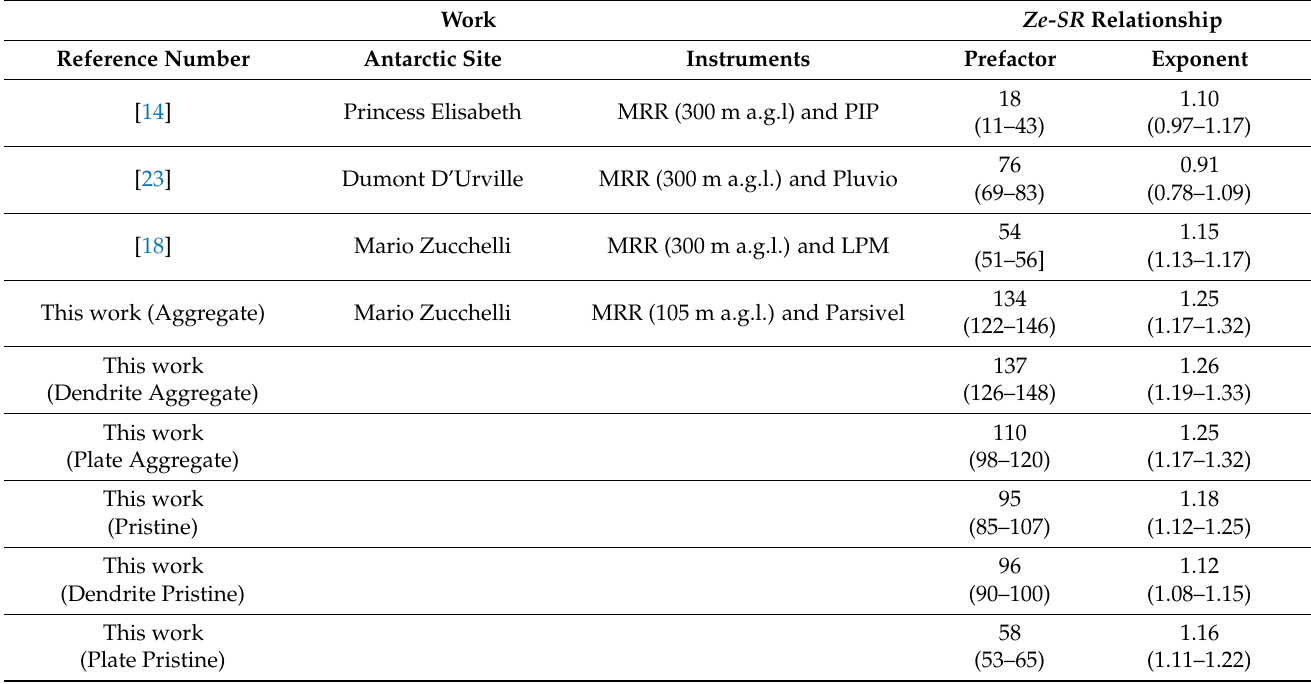
Table 2. List of the Ze-SR parameters in the literature for Antarctic sites and those found and used in this work. The location and the instrumentation set of each work are also included. Values in the brackets in the last two columns represent the confidence